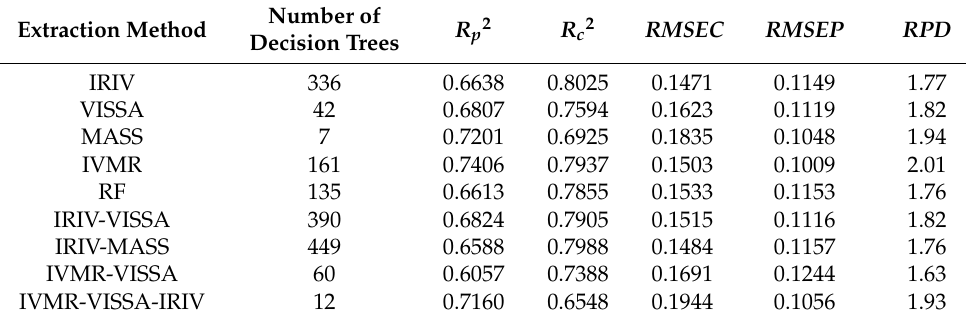
Table 5. The prediction results of RFR.